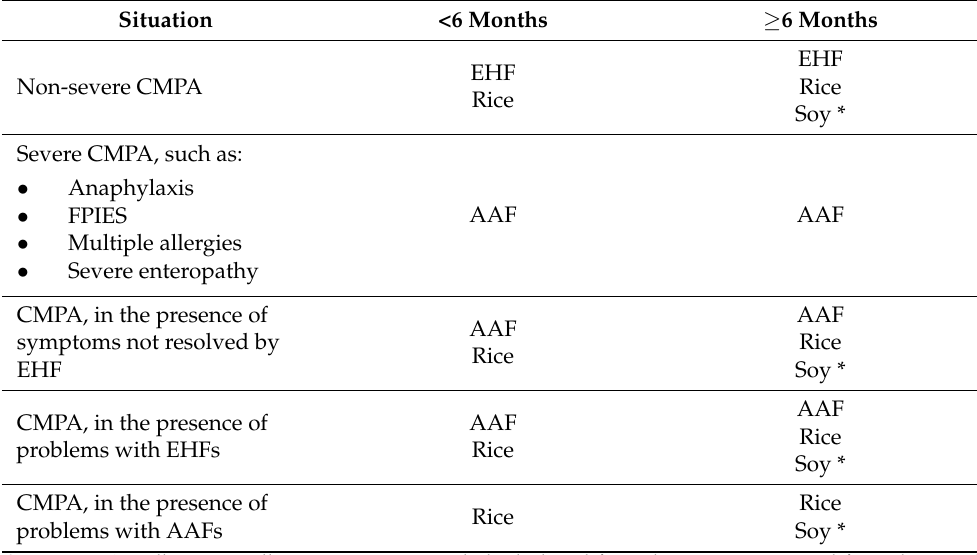
Table 3. Suggestions for the use of formulas in cow’s-milk protein allergy (CMPA) [9,16,22,24,25,50,51]. Situation <6 Months ≥ 6 Months Non-severe CMPA